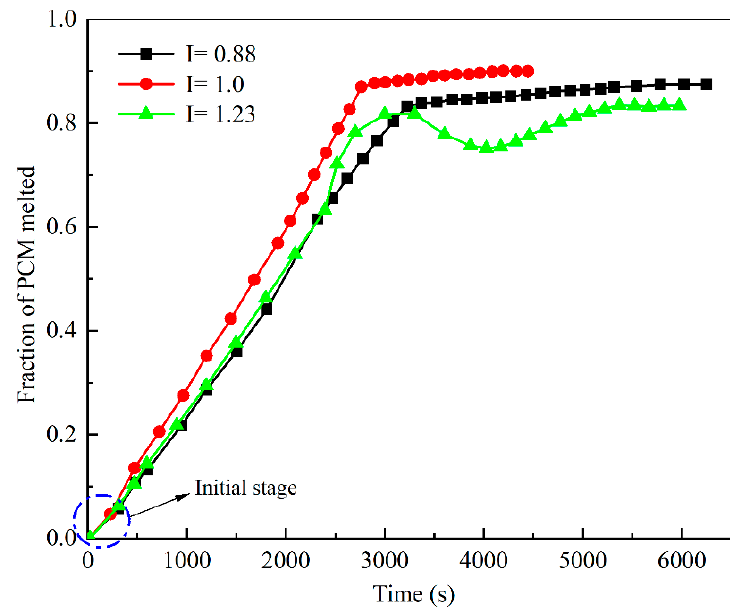
Figure 11. Melting times of PCM at different I values.